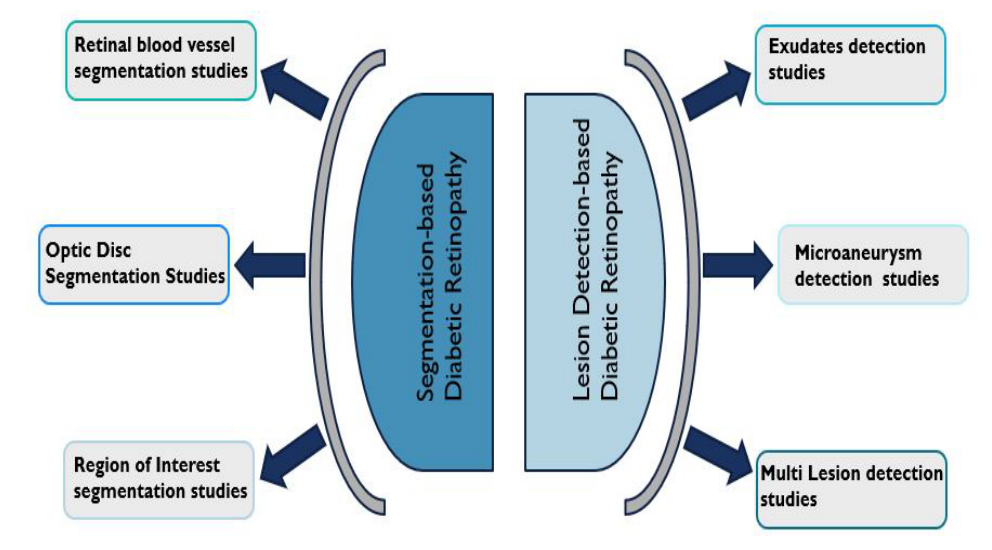
Figure 3. Categorisation of Diabetic Retinopathy studies